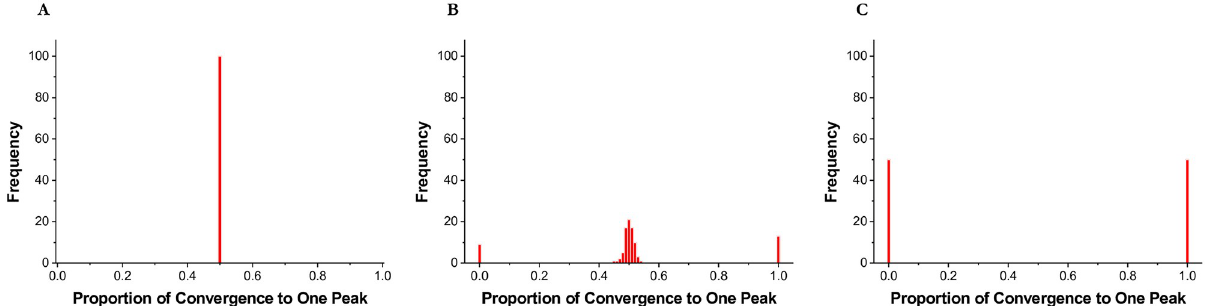
Fig 4. Distribution after convergence. On the horizontal axis, we indicate the proportion of individuals who converge to one peak (we picked the R 1 peak.). On the vertical axis, we indicate the frequency of each proportion out of 100 independent runs. (A) σ = 0.3 (B) σ = 0.83 (C) σ = 1.0.